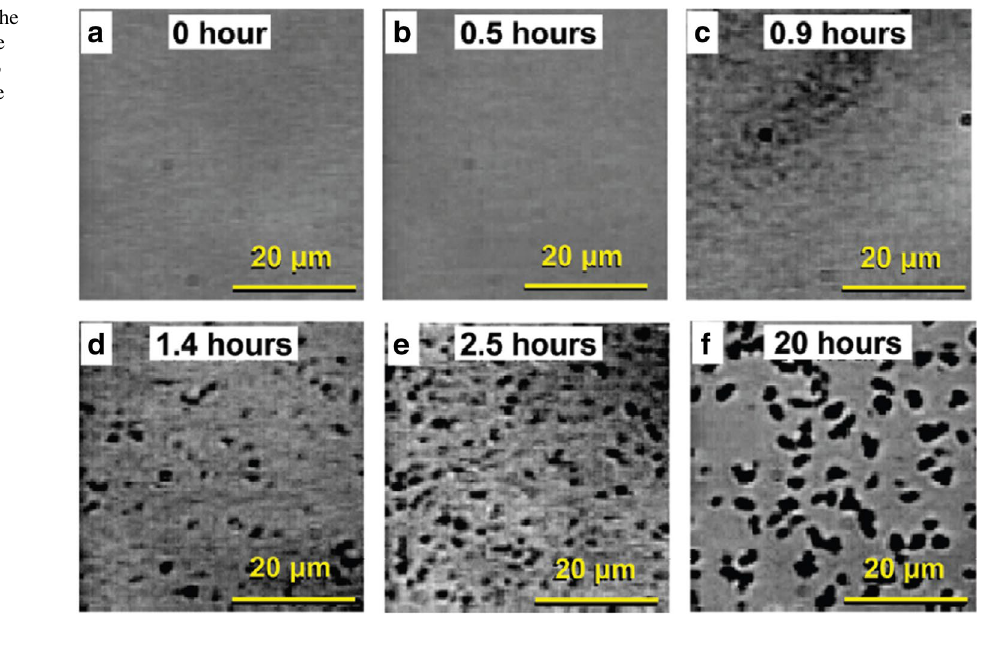
Fig. 8 Micrographs showing the time dependence of asphaltene precipitation for a 50:50 vol.%